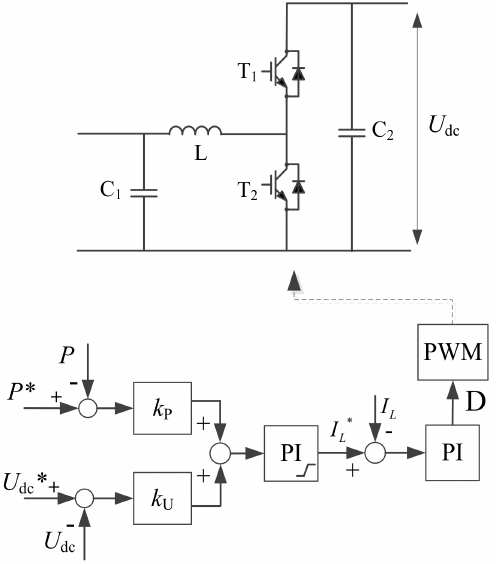
Figure 3. Topology of bidirectional DC/DC converter and its droop controller